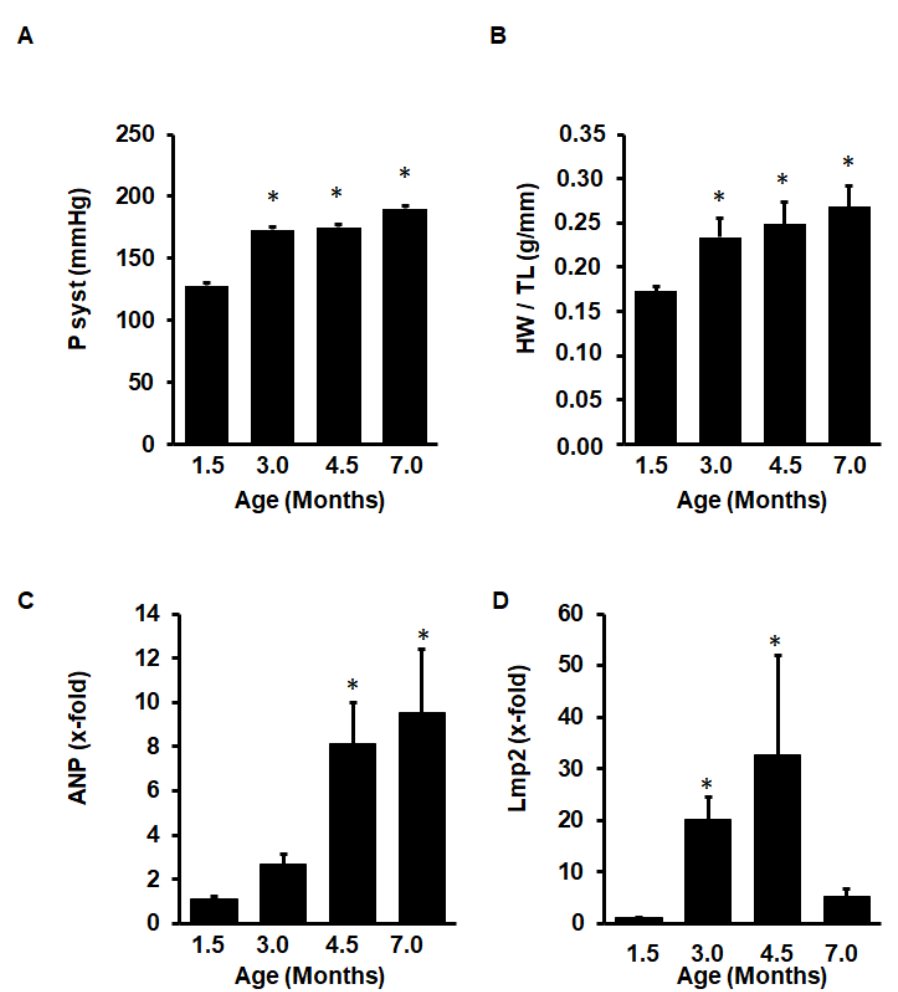
Figure 8. Expression of LMP-2 in spontaneously hypertensive rats. Data show the increase in blood pressure during ageing ( A ), the increase in heart weight to tibia length (HW/TL) as a parameter of hypertrophy ( B ), the induction of atrial natriuretic peptide (ANP; C ), and the mRNA expression of LMP-2 ( D ) in the animals after 1.5–7.0 months as indicated. Data are means ± SD from n = 6 rats. *; p < 0.05 vs. 1.5 months.